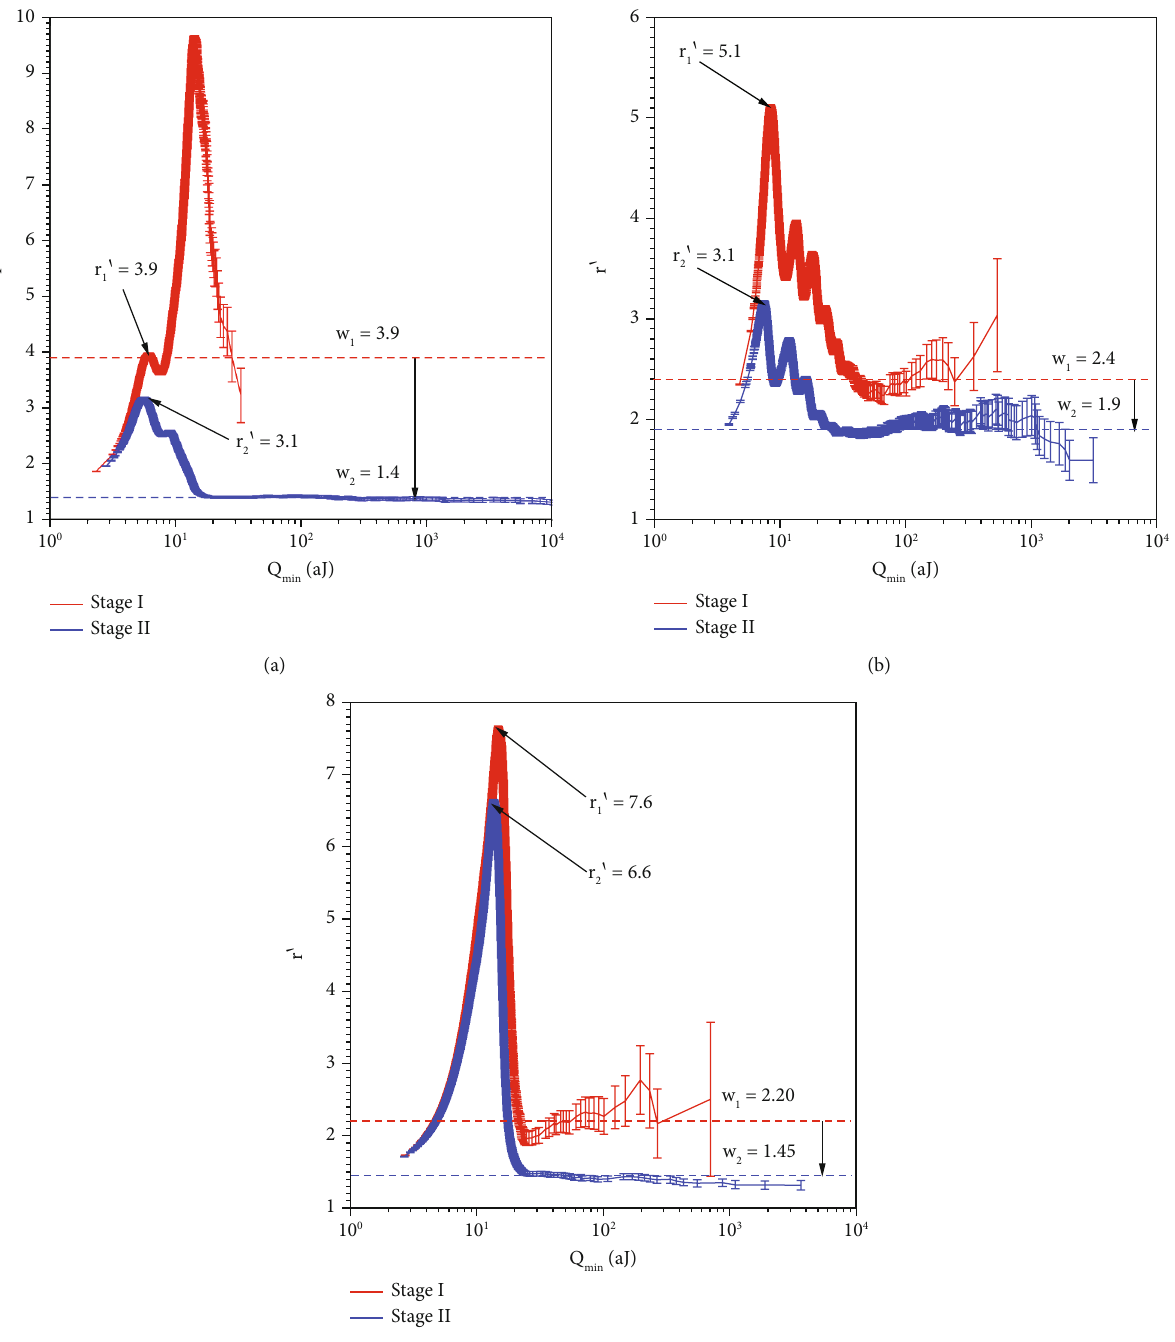
Figure 6: The fi tted exponent r ′ as a function of the lower threshold Q show the standard error, and the dotted line de fi nes the value of the optimal